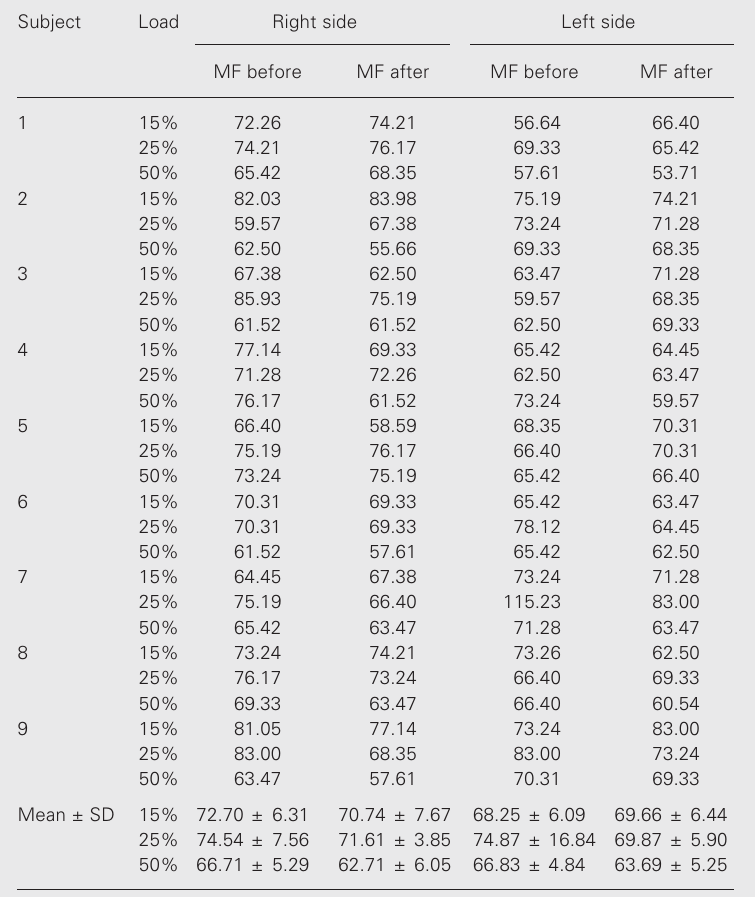
Table 1. Median frequency (MF in Hz) before and after the 1-min test on both the right and left sides with the application of 15, 25 and 50% of maximum